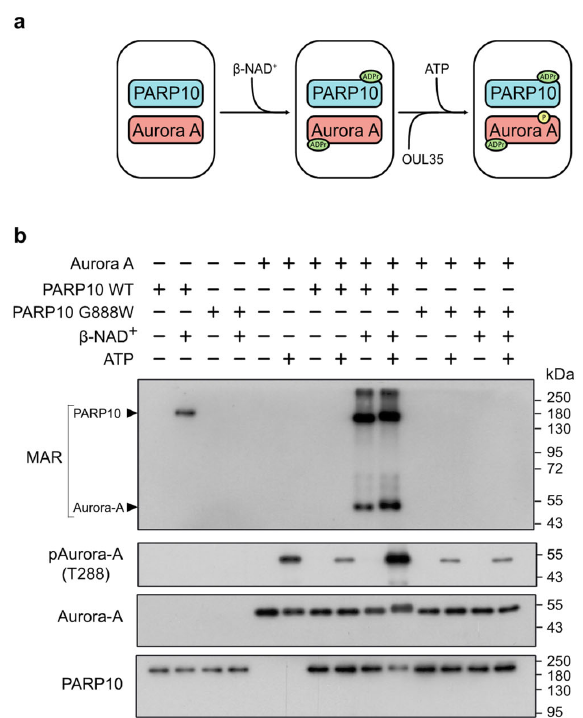
Figure 3. PARP10 enhances Aurora-A kinase activity in vitro. ( a ) Schematic illustration of the two-step ADP-ribosylation/kinase assay using purified GST-PARP10 or its catalytically inactive mutant (GST-PARP10-G888W) and His-Aurora-A. ( b ) Two-step ADP-ribosylation/kinase assay. ADP-ribosylated proteins were detected using an anti-MAR/PAR antibody. Phosphorylated Aurora-A was evaluated using an anti-phospho-T288 Aurora-A antibody. Levels of PARP10 and Aurora-A were controlled by using an anti-PARP10 antibody and an anti-Aurora-A antibody, respectively. Results shown are representative of three independent experiments. Full pictures of the Western blots are presented in Figure S6.